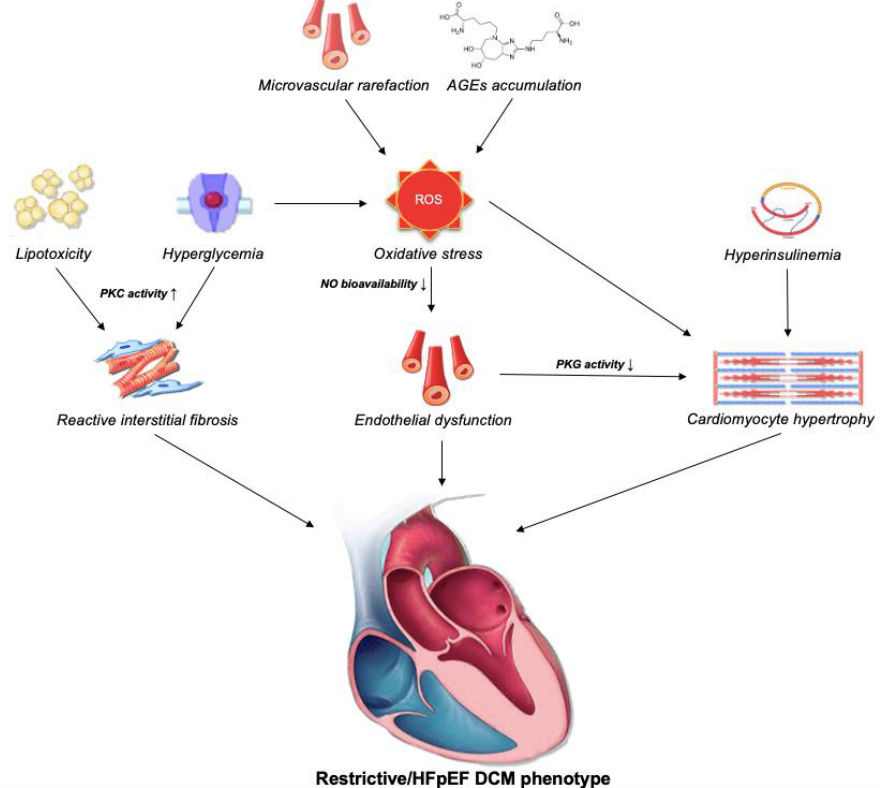
Figure 2. Pathophysiological mechanisms underlying the “restrictive” DCM phenotype. Hypergly- cemia, lipotoxicity, AGE accumulation, and microvascular rarefaction all contribute to the development of endothelial dysfunction. Subsequently, lack of NO bioavailability leads to myocardial hypertrophy by down-regulation of PKG activity, which is further supported by hyperinsulinemia. Finally, pathological hypertrophy dampens diastolic function of the myocardium. On the other hand, hyperglycemia and lipotoxicity increase PKC activity, thus leading to reactive interstitial fibrosis that further dampens diastolic function and contributes to the development of HFpEF.